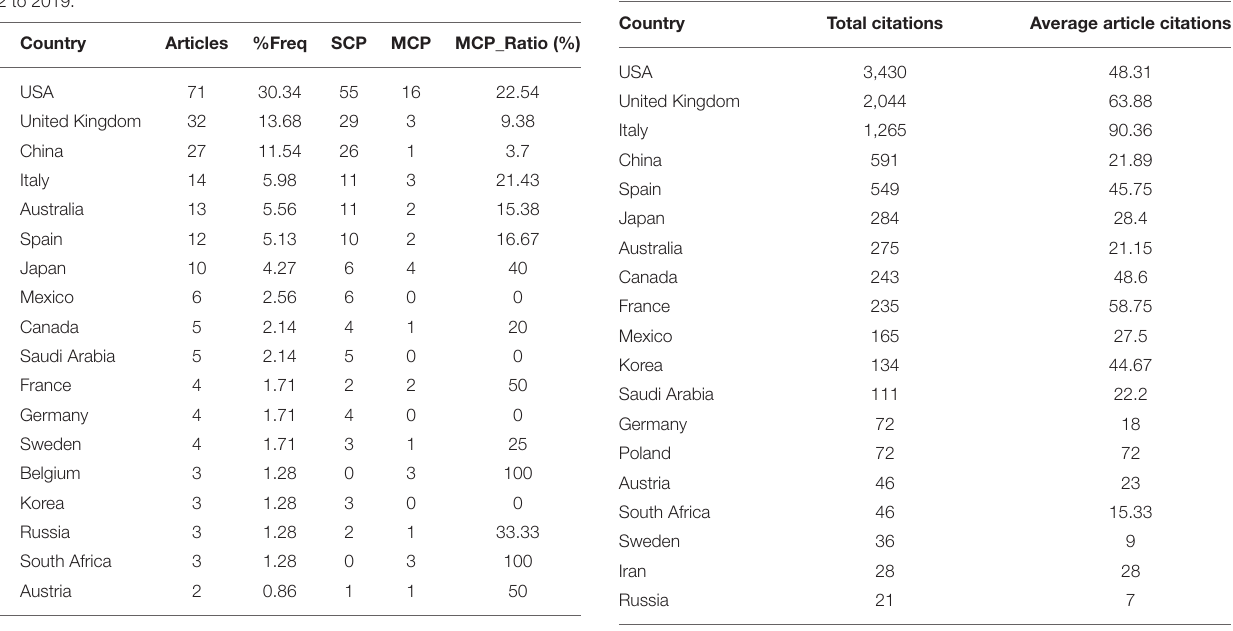
TABLE 5 | Total citations per country on MPP-AD research from 1982 to